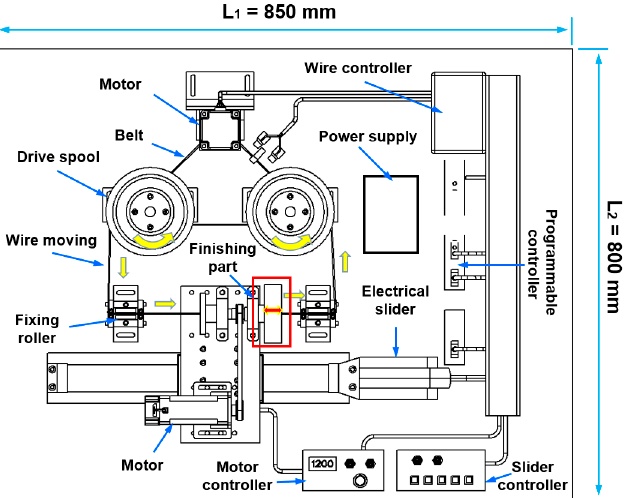
Figure 1. 2D view of the experimental set-up for surface finishing of Ni-Ti (nitinol) wire using the MAF process.